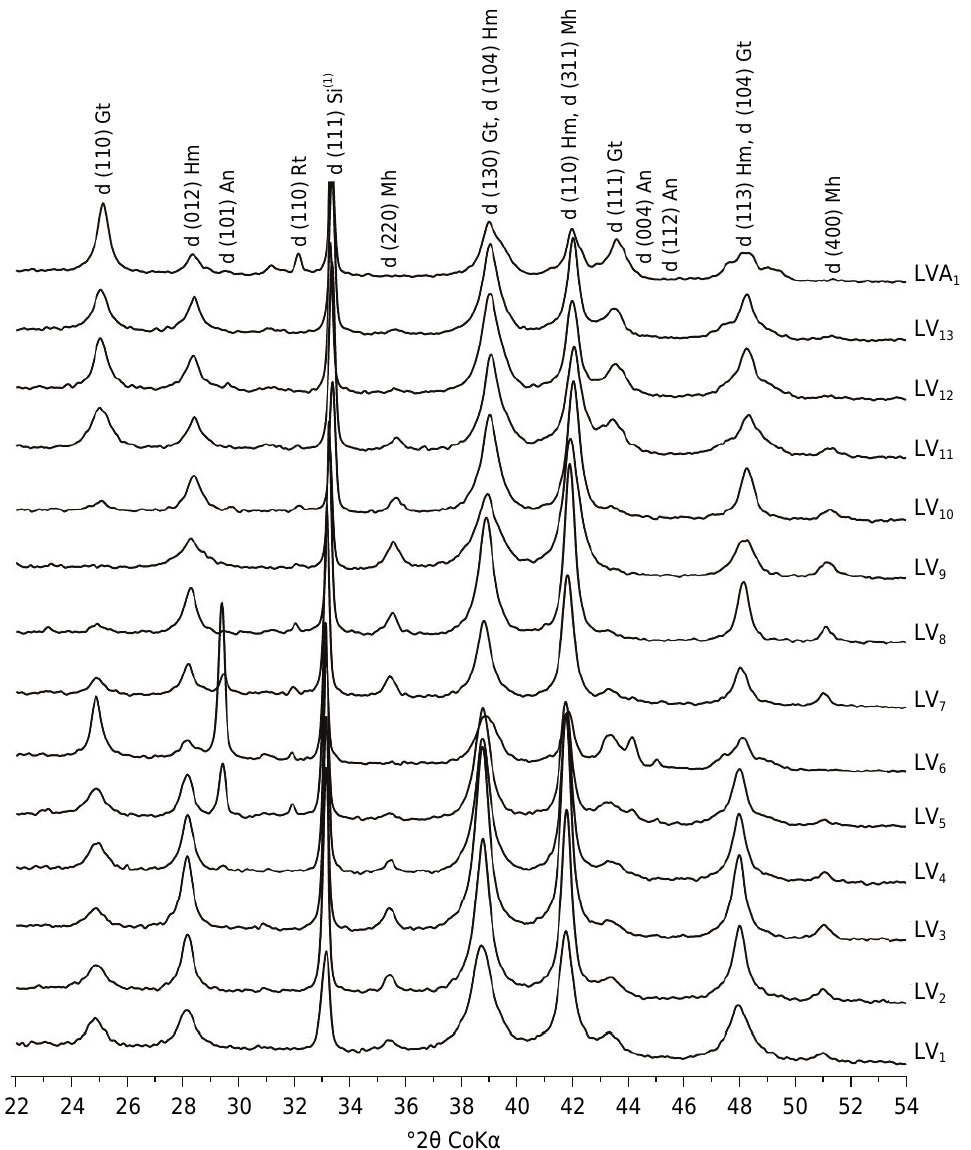
Figure 2. X ray patterns from the clay fraction after treatment for Fe oxide concentration. (1) Internal standard